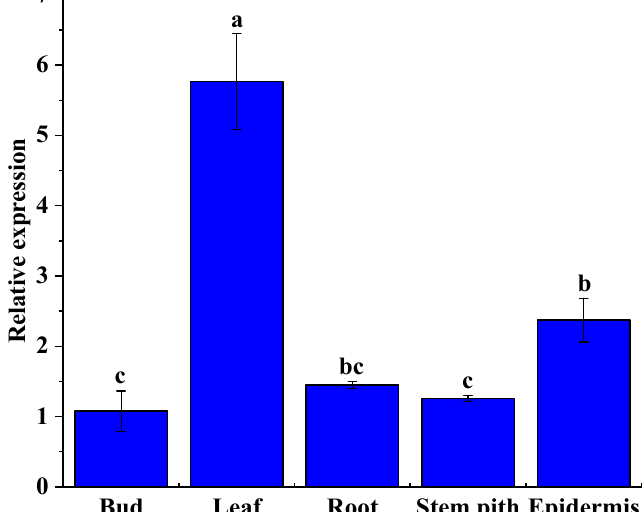
Figure 8. Tissue-specific expression analysis of ShNPR1 in 10-month-old sugarcane ROC22 plants by qRT-PCR analysis. The expression level of glyceraldehyde-3-phosphate dehydrogenase ( GAPDH ) was used for data normalization. The bars represent the mean ± standard error ( n = 3). Different lowercase letters on the top of the bars indicate the significant differences determined by Duncan’s new multiple range test ( p -value < 0.05).